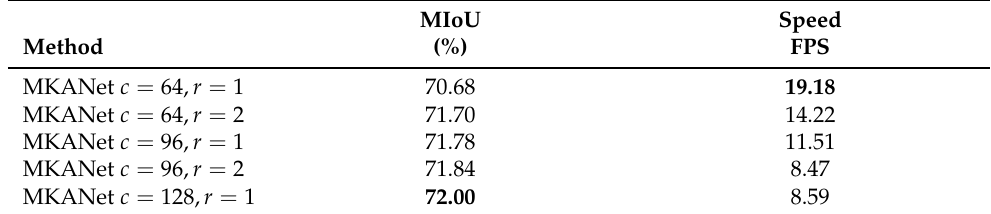
Table 10. Comparison of MKANets with different widths and